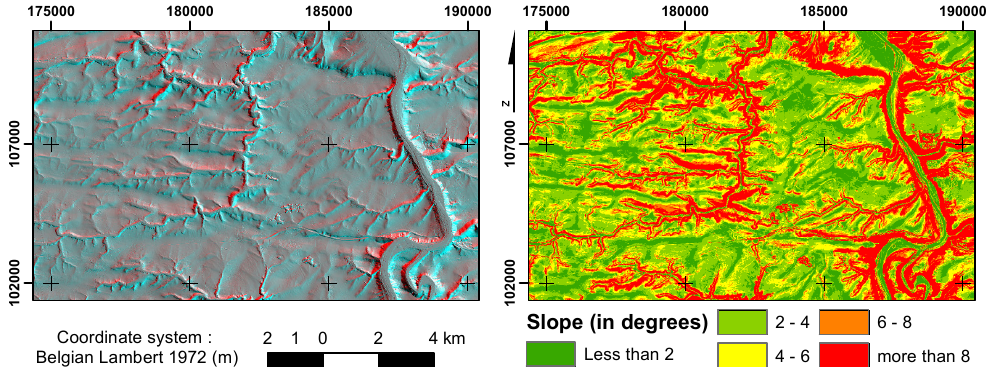
Figure 3. False color composite of the hillshades along the North-South and East-West directions ( left ) and slope derived from the LIDAR images ( right ) on a subset of the study area. Shades of grey indicate that the hillshade values in the two orthogonal directions are equal while colored areas highlight the differences between the two